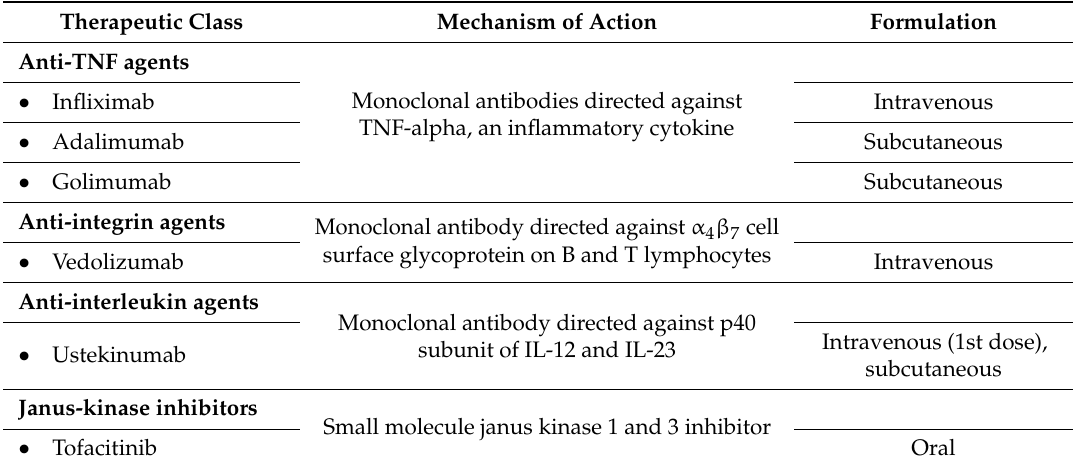
Table 2. Moderate-severe ulcerative colitis